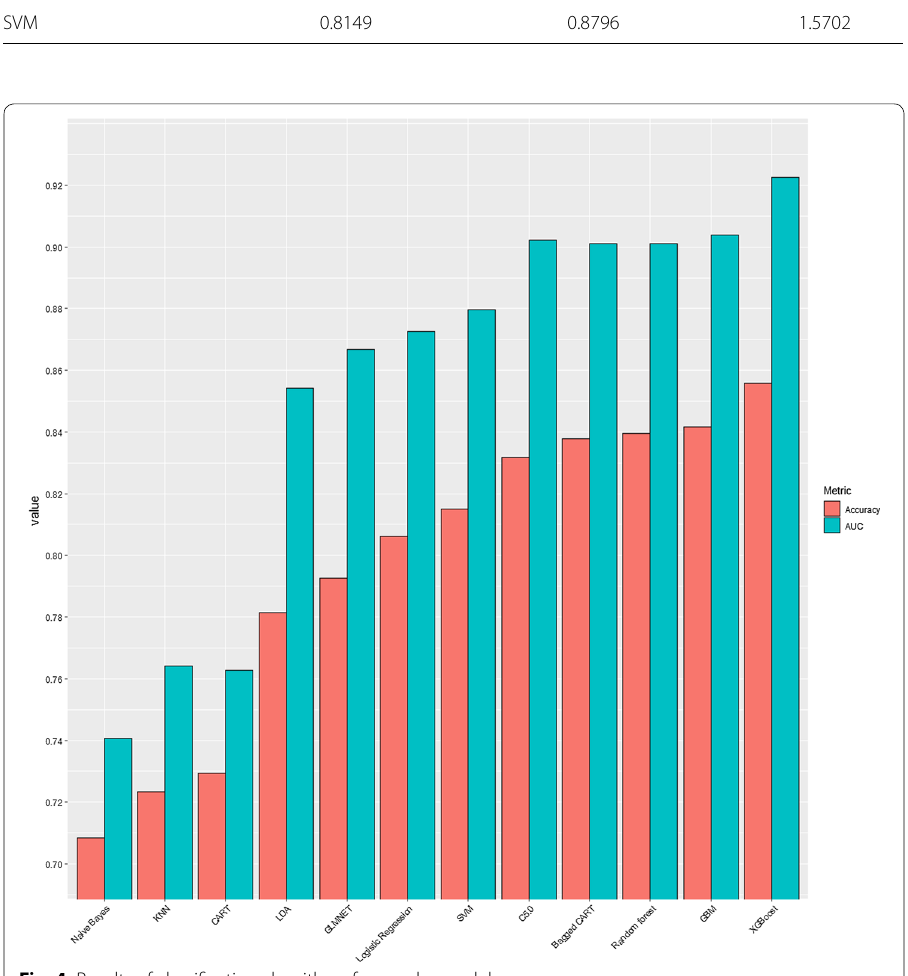
Fig. 4 Results of classification algorithms for gender